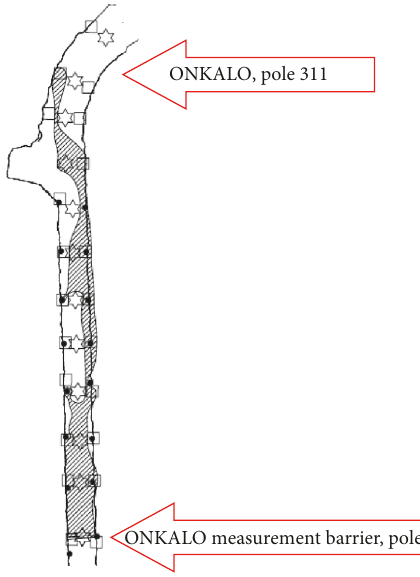
Figure 20: Antenna 2 front reading area.